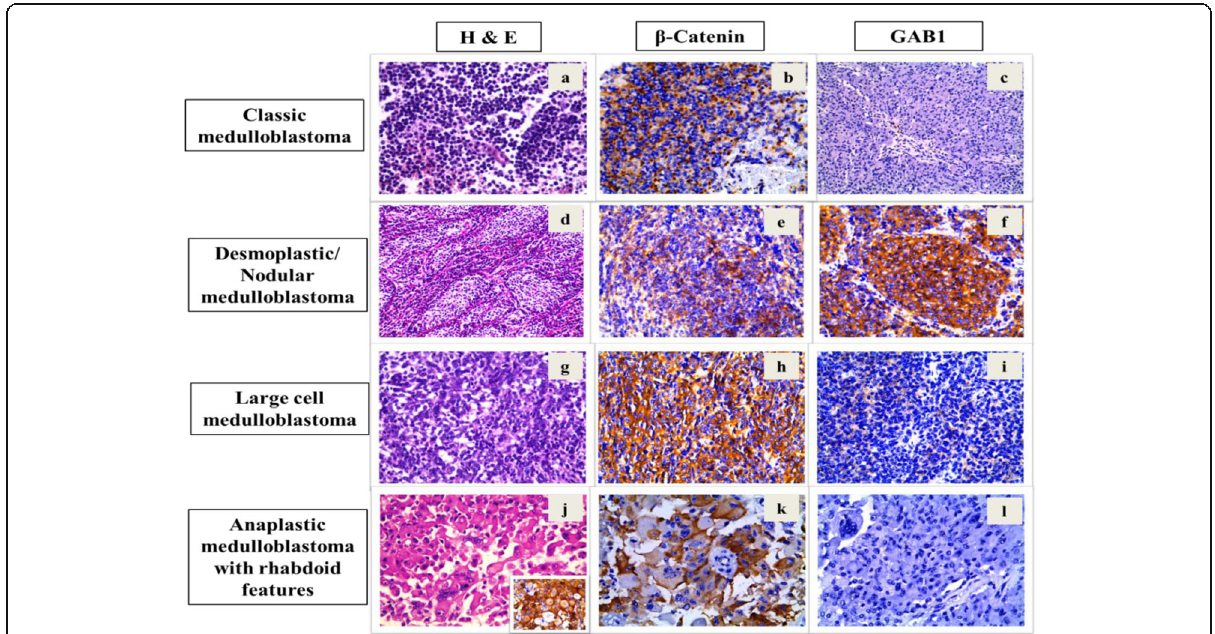
Fig. 1 Histopathological and immunohistochemical results of MB cases. ( a ) H&E sections of classic histology (× 400), ( b ) nuclear immunoreactivity for β -catenin (× 400), ( c ) negative cytoplasmic staining for GAB1 (× 200); Both b and c characterize WNT pathway of MB, ( d ) H&E sections of D/N histology revealed nodular configuration with intervening desmoplasia (× 200), ( e ) negative nuclear expression for β -catenin (with cytoplasmic immunoreactivity) (× 400), ( f ) strong cytoplasmic staining for GAB1 (× 400); both e and f denote SHH profile, ( g ) H&E sections of large cell MB, ( h ) negative nuclear expression for β -catenin (with cytoplasmic reaction) (× 400), ( i ) negative cytoplasmic reactivity for GAB1 (× 400), ( j ) H&E sections of anaplastic MB with rhabdoid features exhibiting abundant eosinophilic glassy cytoplasm with eccentric nuclei and scattered multinucleated giant cells; confirmed by positive cytoplasmic staining for synaptophysin (inset) (× 400), ( k ) negative nuclear/positive cytoplasmic expression for β - catenin (× 400), ( l ) negative cytoplasmic reaction for GAB1 (× 400); h , i , k , and l characterize non-WNT/SHH subgroup of